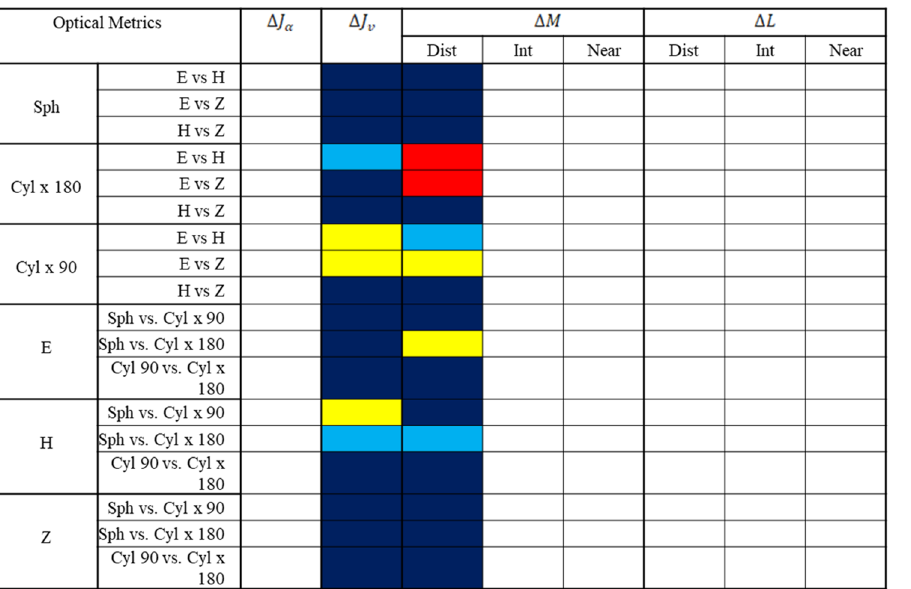
Table 3. Summary of post-hoc test results for different metrics. This statistical summary indicates the level of significance obtained with metrics showing interaction between manufacturer and prescription type, namely (cid:31) J v and (cid:31) M metric. The color code of the p-value is the following: dark blue, p > 0.05 (not significant); light blue, p 0.05; yellow, p 0.01; red, p 0.001. Note that the blank field corresponds to the conditions where the ≤ ≤ ≤ statistical test is not applicable. H Hoya, E Essilor, Z